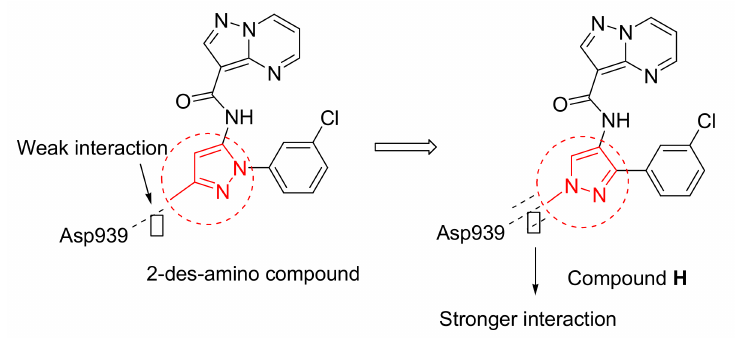
Figure 49. Schematic view of the steps in development and lead